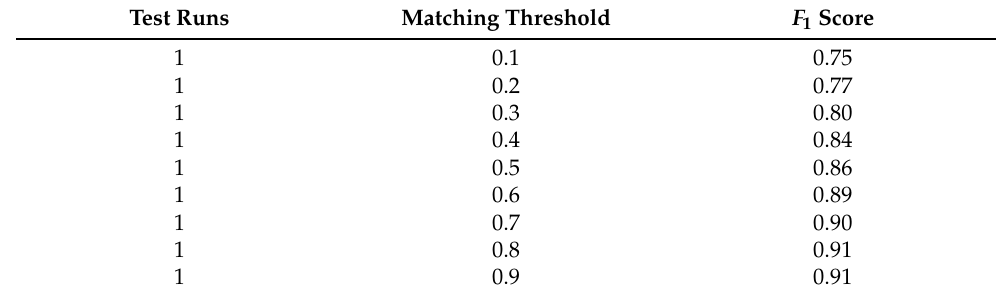
Table 12. Effect of Matching Threshold.